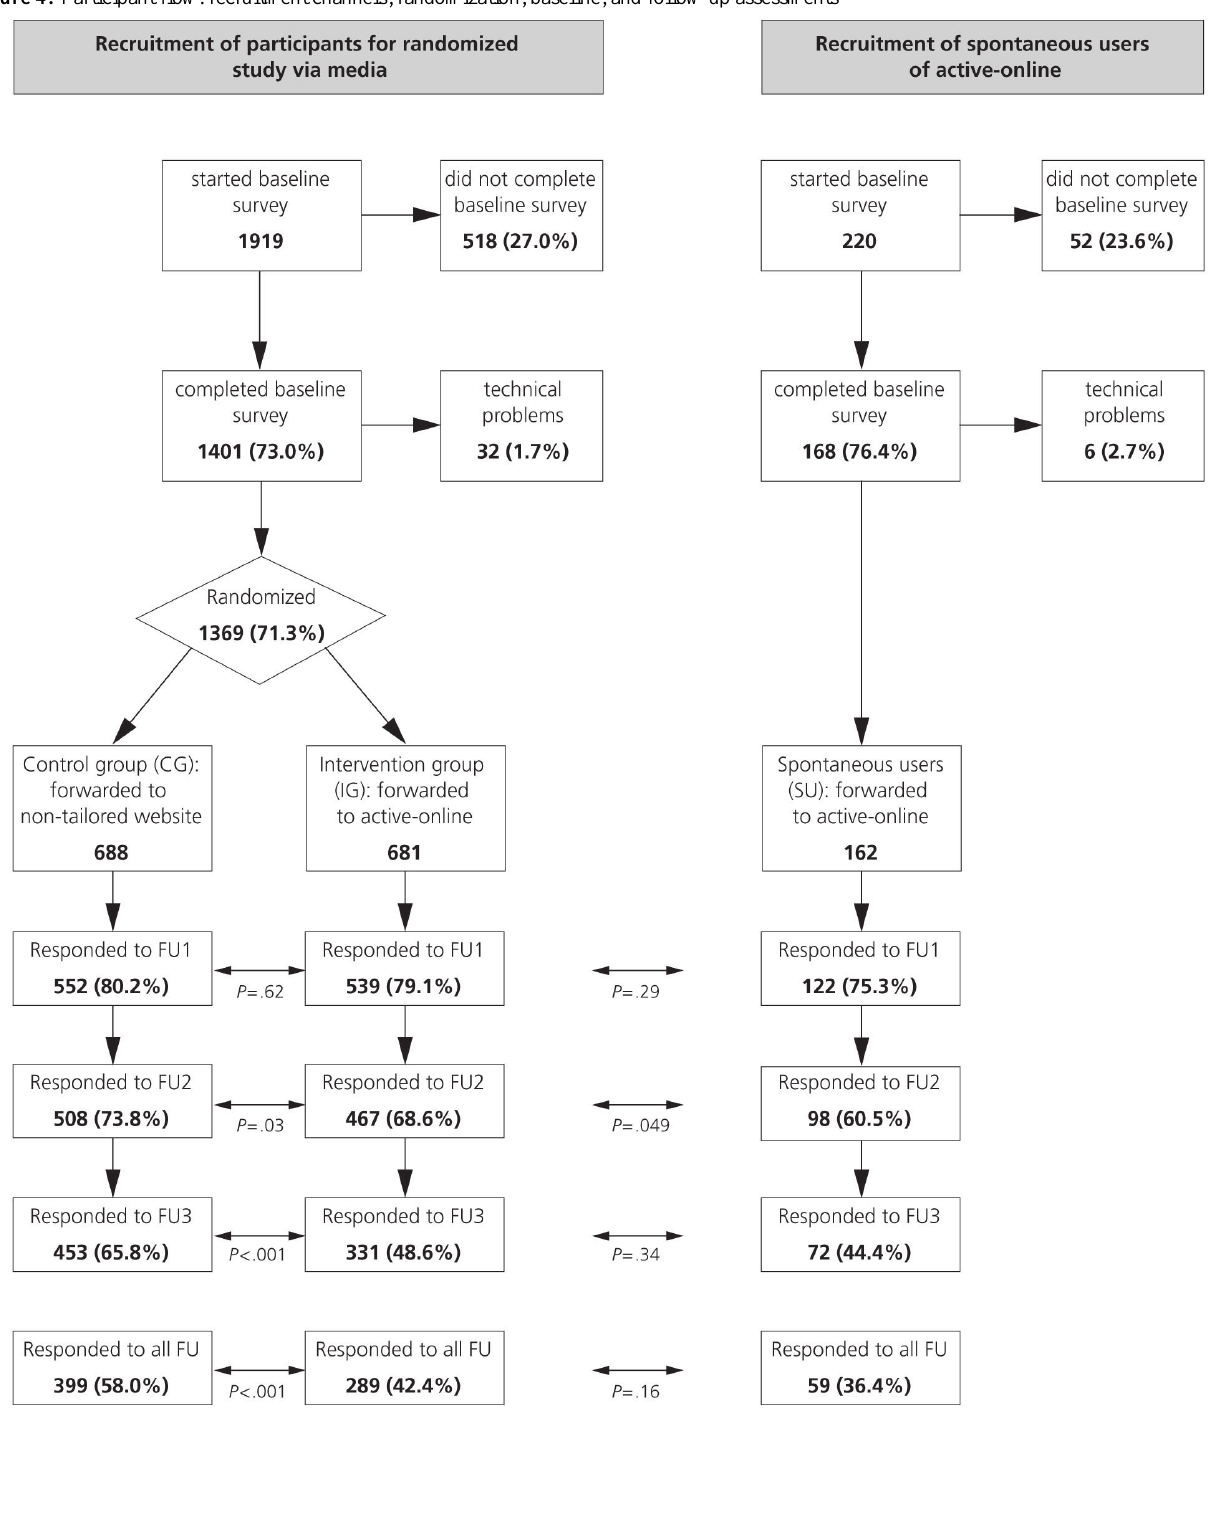
Figure 4. Participant flow: recruitment channels, randomization, baseline, and follow-up